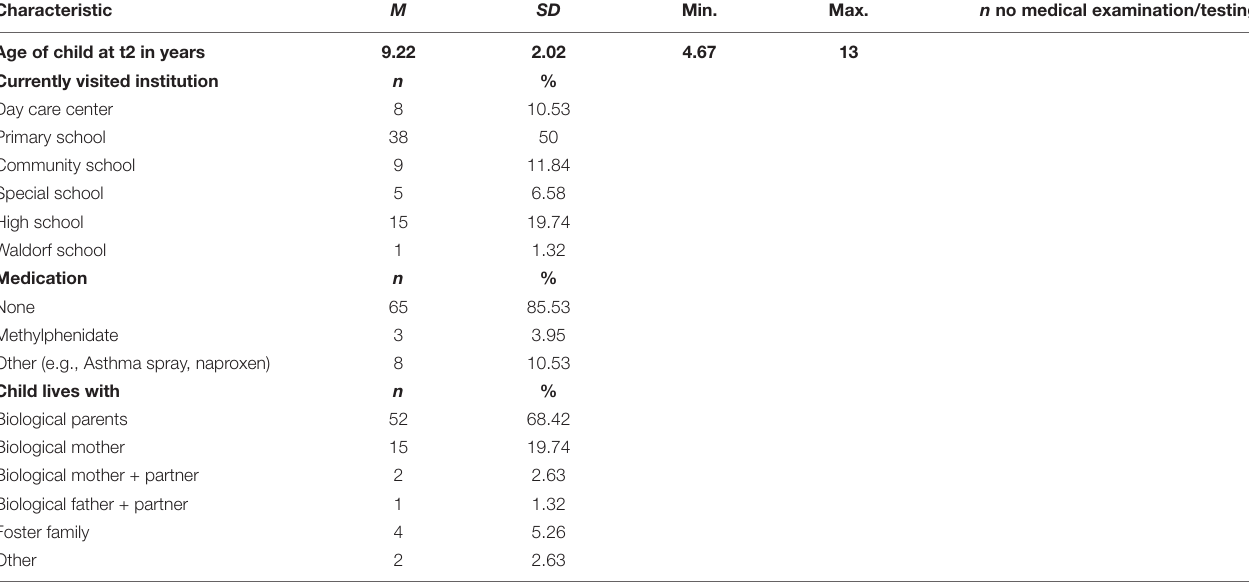
TABLE 2 | Characteristics of sample at t2 ( n = 76).